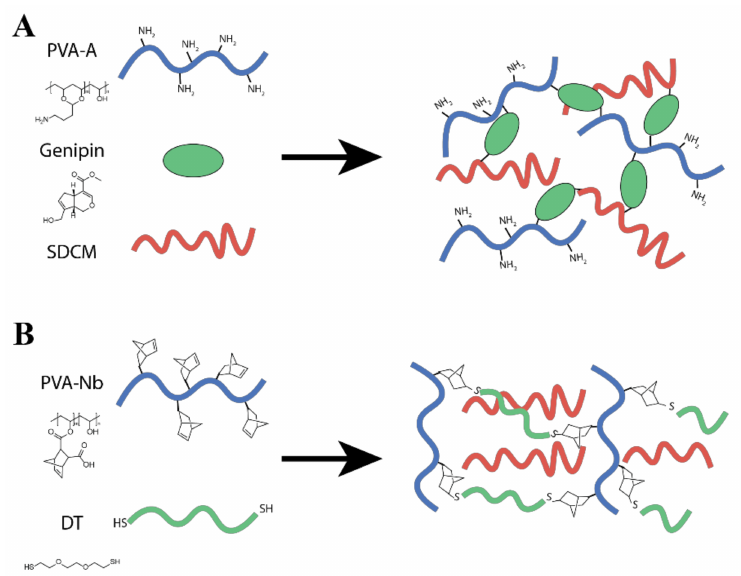
Figure 1. Schematic representations of the ( A ) PVA modified with amine groups (PVA-A)/solubilized decellularized cartilage matrix (SDCM) biomaterial inks formulated from 10 wt% (PVA-A + SDCM) and 0.1% wt/wt genipin and desired PVA-A/SDCM dual-gel. ( B ) PVA functionalized with cis-5- norbornene-endo-2,3-dicarboxylic anhydride (PVA-Nb)/SDCM biomaterial